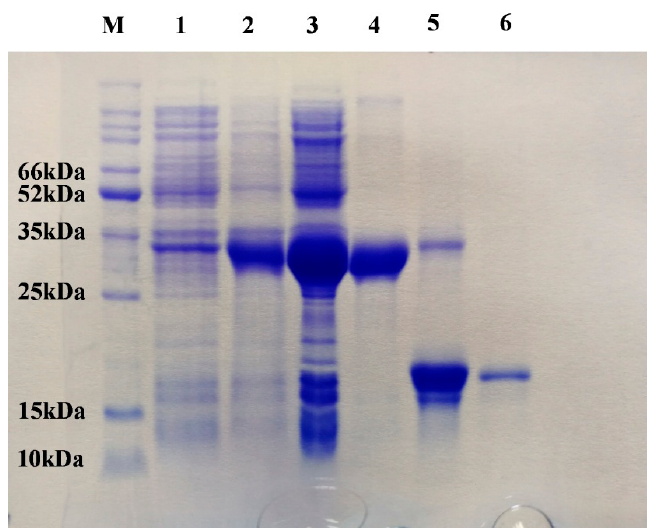
Figure 2. SDS-PAGE analysis, the expression and purification of recombinant SaveOBP9. Lane M: Molecular marker; Lane 1 and 2: Bacterial cells before and after induction by IPTG, respectively; Lane 3: Inclusion body of induced BL21 (DE3) bacteria with pET-32a/SaveOBP; Lane 4: Supernatant of induced BL21 (DE3) bacteria with pET-32a/SaveOBP9; Lane 5: Digestion of recombinant protein with bovine Enterokinase; Lane 6: Purified protein without His-tag. Table 1. Binding affinities of different ligands to SaveOBP9 evaluated via competitive ligand binding assays by using the fluorescent probe, 1-NPN.